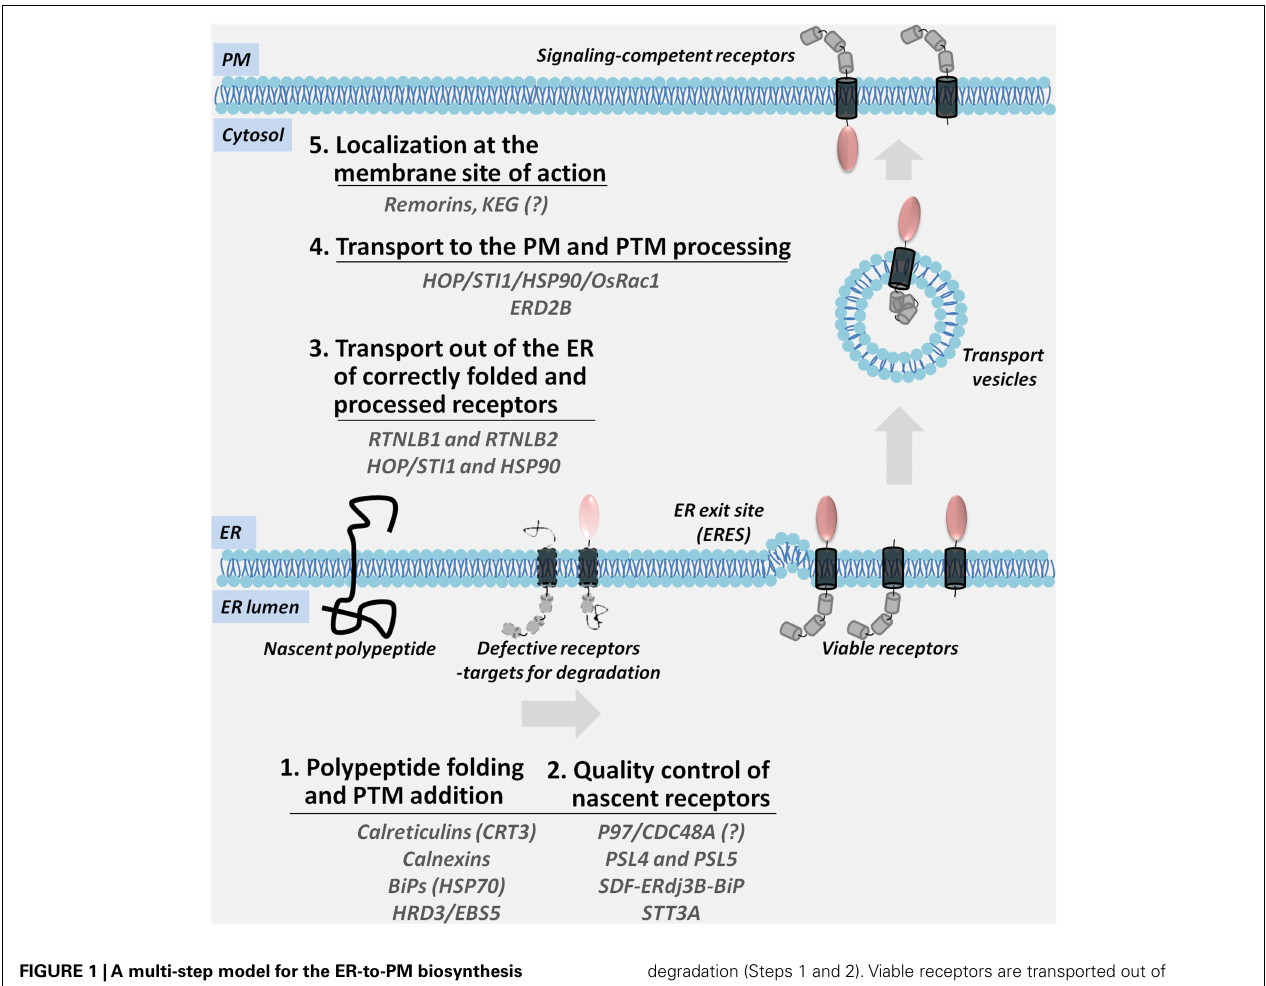
FIGURE 1 |A multi-step model for the ER-to-PM biosynthesis and trafficking of PM-associated signaling receptors. Nascent polypeptides are translocated into the ER membrane where they are subjected to the ER-resident folding and post-translational modification (PTM) machinery; defective receptors are recognized by the components of the ER quality control and directed for